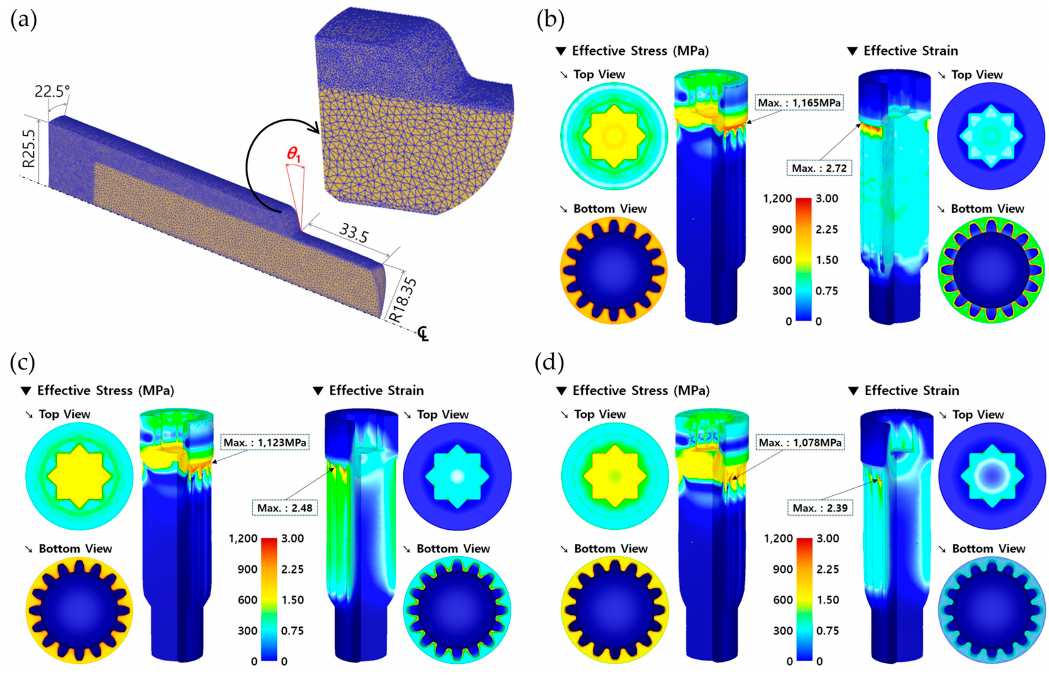
Figure 9. ( a ) Reconstructed mesh structure with about 330,000 tetrahedral elements (unit: mm); ( b ) effective stress and strain distribution with a θ 1 = 30° and a θ 2 = 30°; ( c ) effective stress and strain distribution with a θ 1 = 45° and a θ 2 = 45°; ( d ) effective stress and strain distribution with a θ 1 = 60° and a θ 2 = 60°.